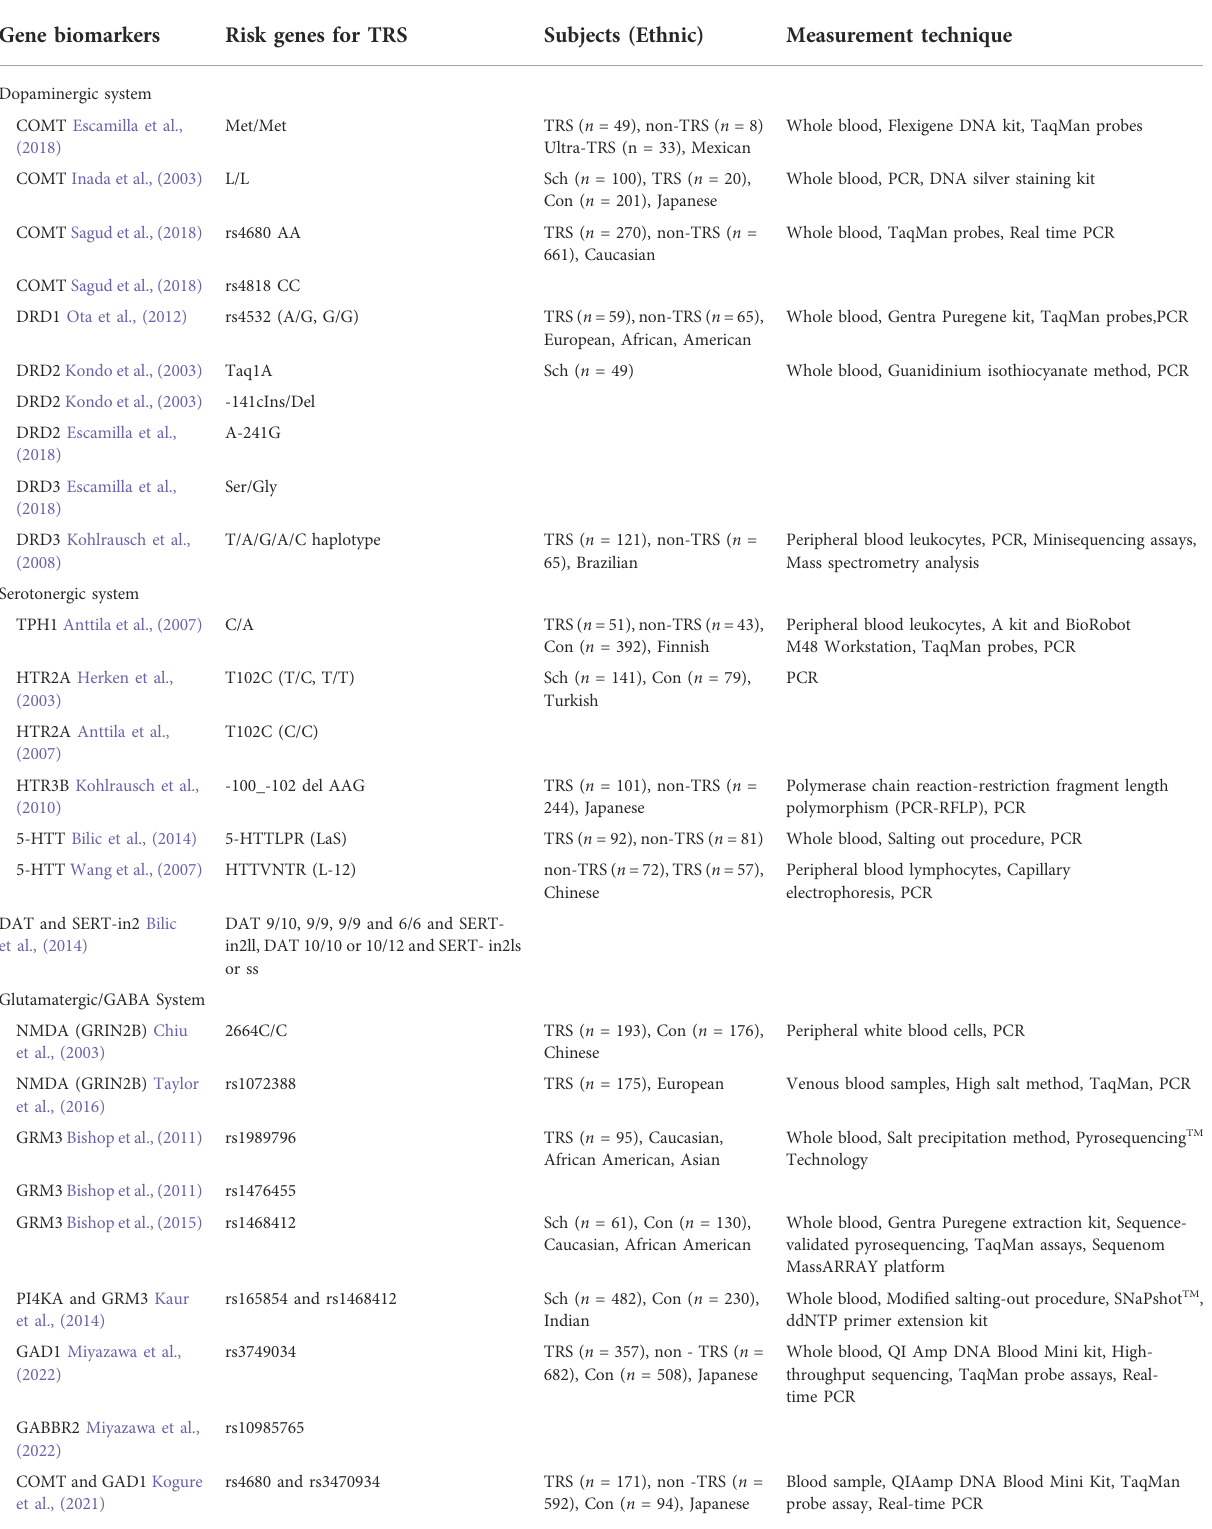
TABLE 1 Genetic biomarkers of treatment resistant